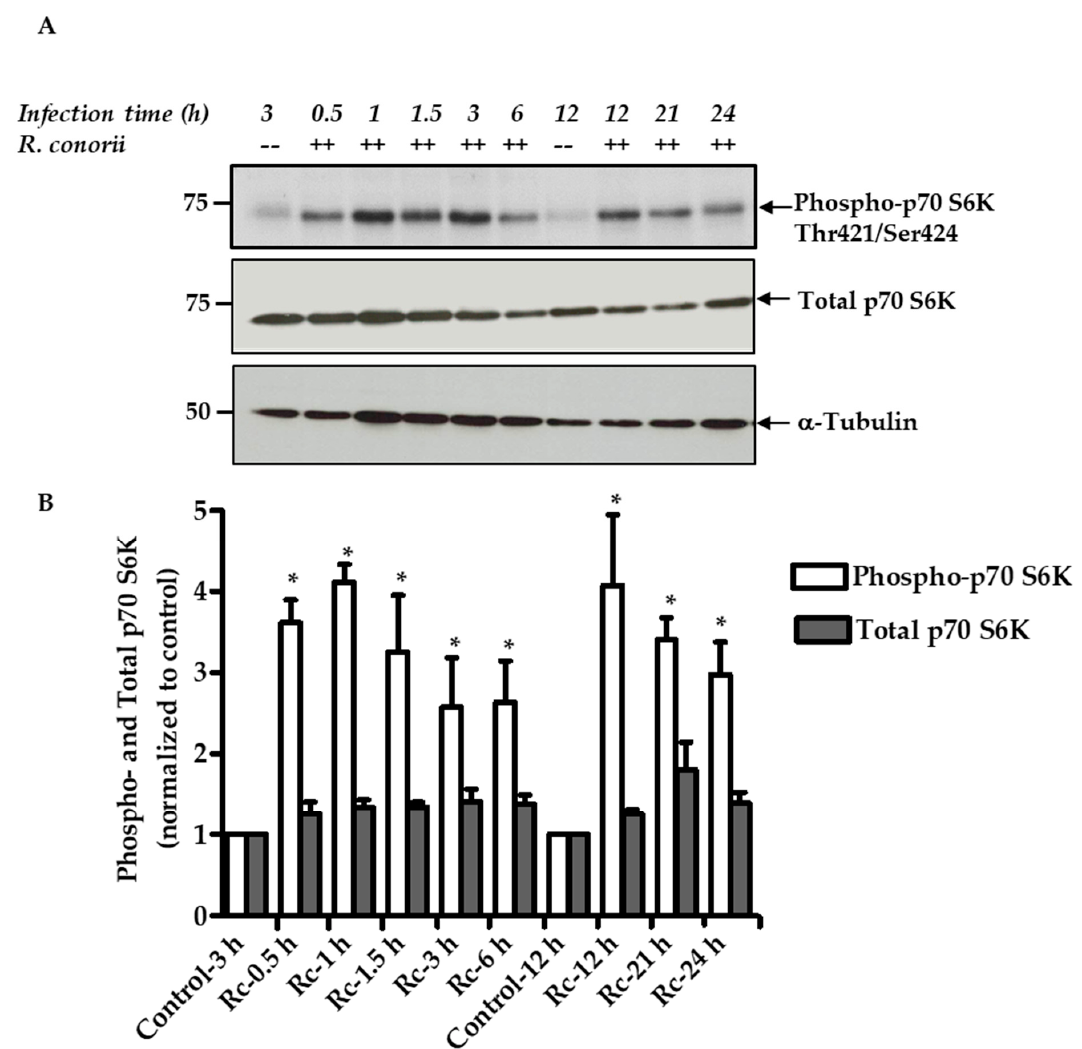
Figure 1. Mechanistic target of rapamycin complex 1 (mTORC1) activation in R. conorii -infected endothelial cells (ECs). ( A ). Confluent monolayers of human umbilical vein endothelial cells (HUVECs) were either mock infected (–) or infected with R. conorii ( ++ ) at a multiplicity of infection (MOI) of 5 plaque-forming units (PFUs) per cell for various times as indicated. Protein lysates were then prepared by cell lysis and subjected to immunoblot analysis with antibodies against phospho- and total p70 S6 kinase (p70 S6K). An α -tubulin antibody was used as a loading control to account for any variations in sample loading on different gel lanes. Relative positions of nearest molecular weight markers (kDa) from the protein ladder are displayed on the left flank of the gel. Results from a representative blot ( n ≥ 3) are presented. ( B ). Quantitative band densitometric analysis of phospho- and total p70 S6 kinase during R. conorii ( Rc ) infection of host ECs is shown as a function of time. The values are presented as the mean ± standard error of the mean (SEM) for at least three independent experiments. For comparison, basal levels in mock-infected cells (controls) were assigned a value of 1. The asterisk (*) indicates statistically significant changes ( p ≤ 0.05) in R. conorii -infected cells compared with the baseline in corresponding samples from uninfected ECs. Similar results were obtained with R. rickettsii .